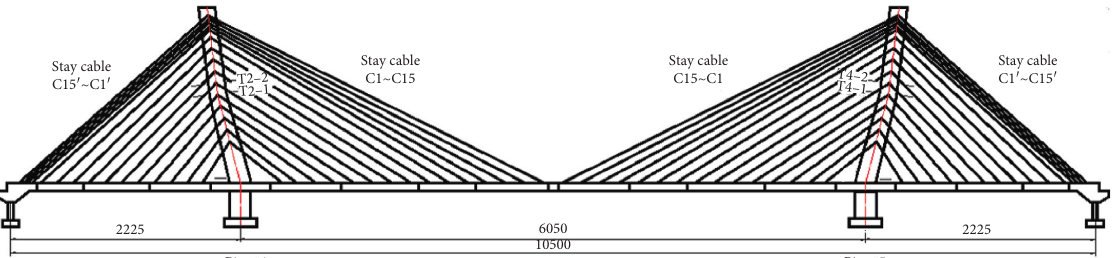
Figure 4: Diagram of testing section arrangement about girder (unit: cm).